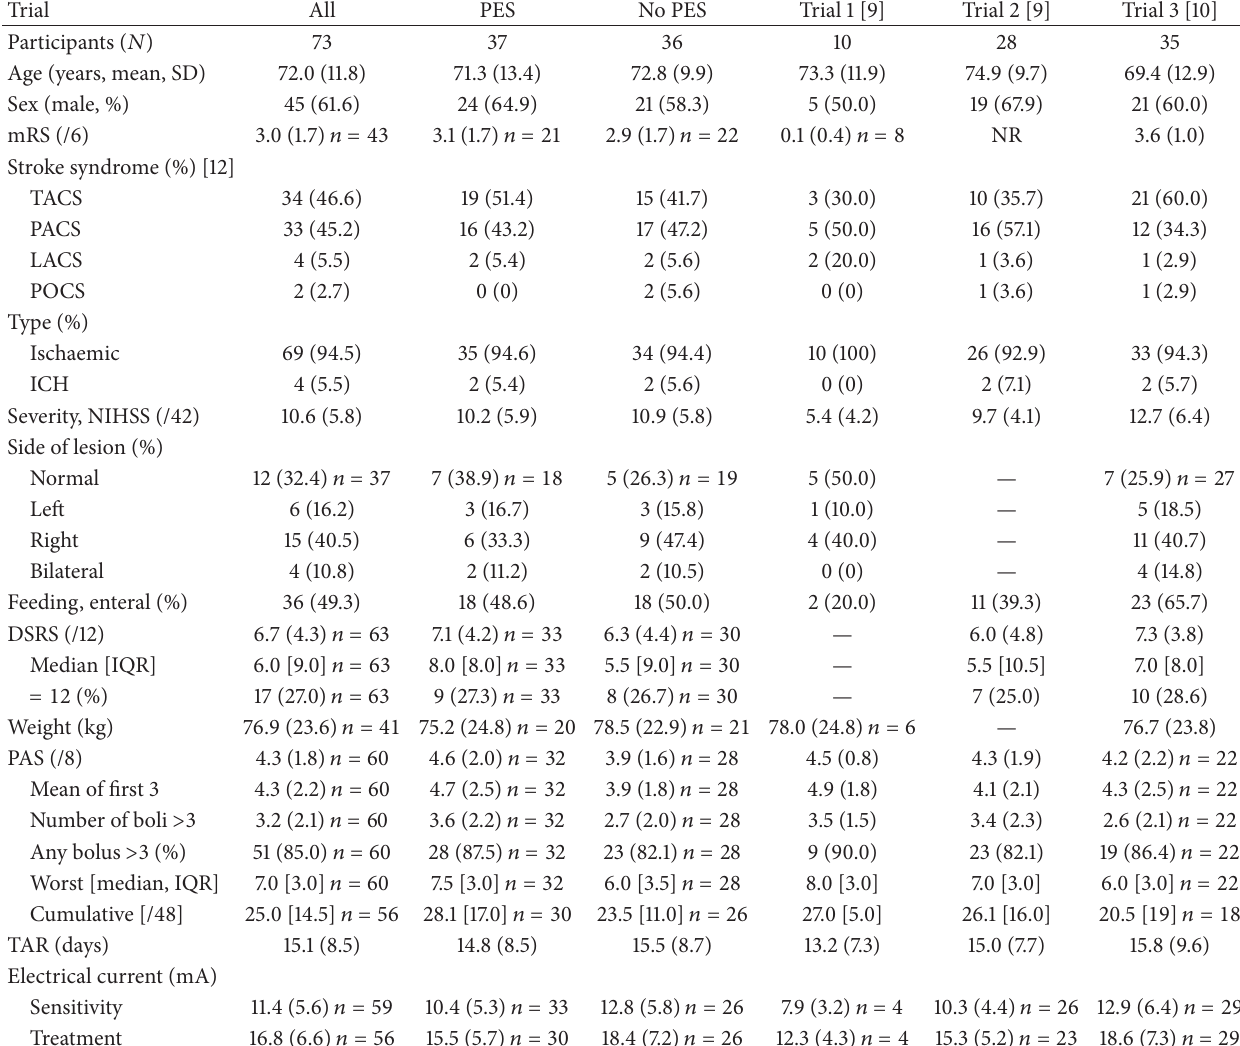
Table 2: Baseline characteristics of participants. Data are number (%), median [interquartile range], or mean (standard